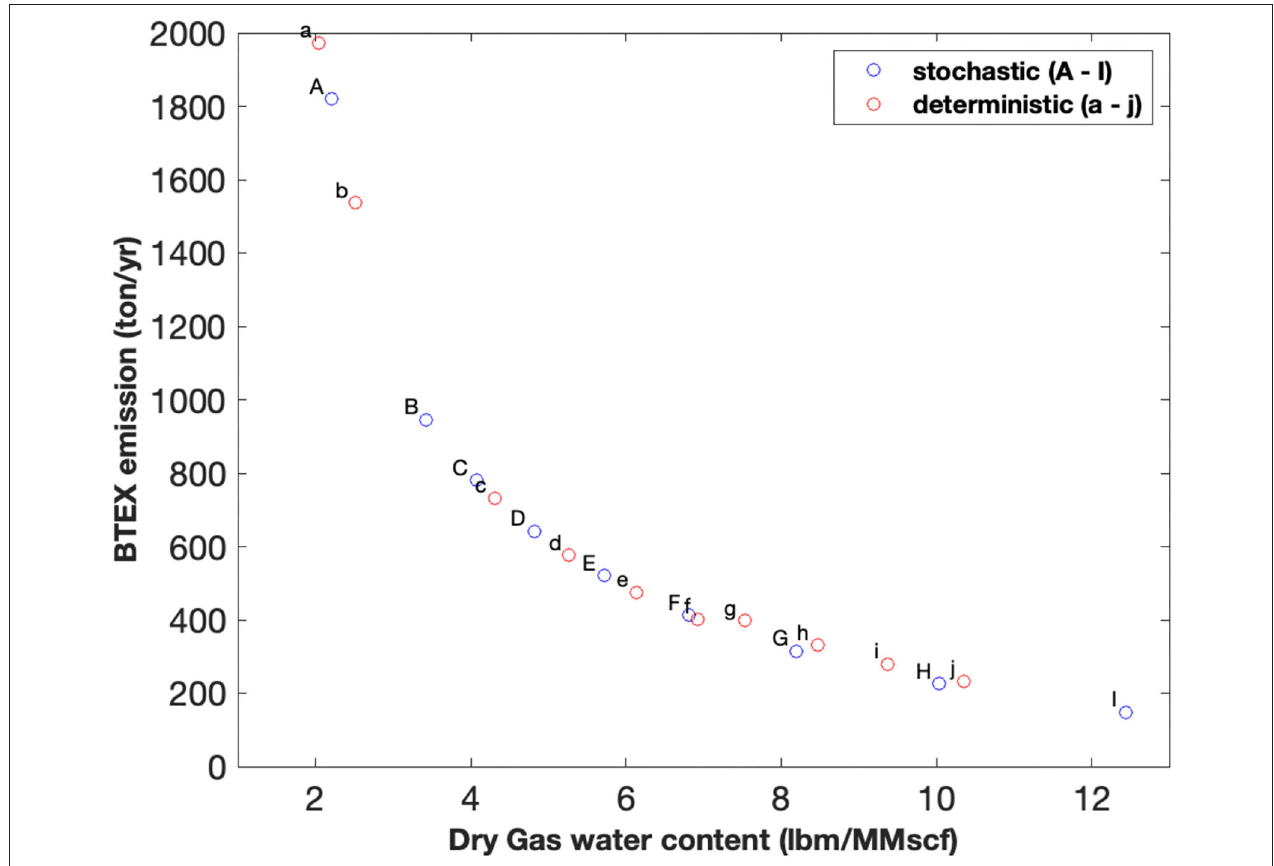
FIGURE 8 | Pareto optimal points predicted by RBRMOO stochastic and MOO deterministic optimization.